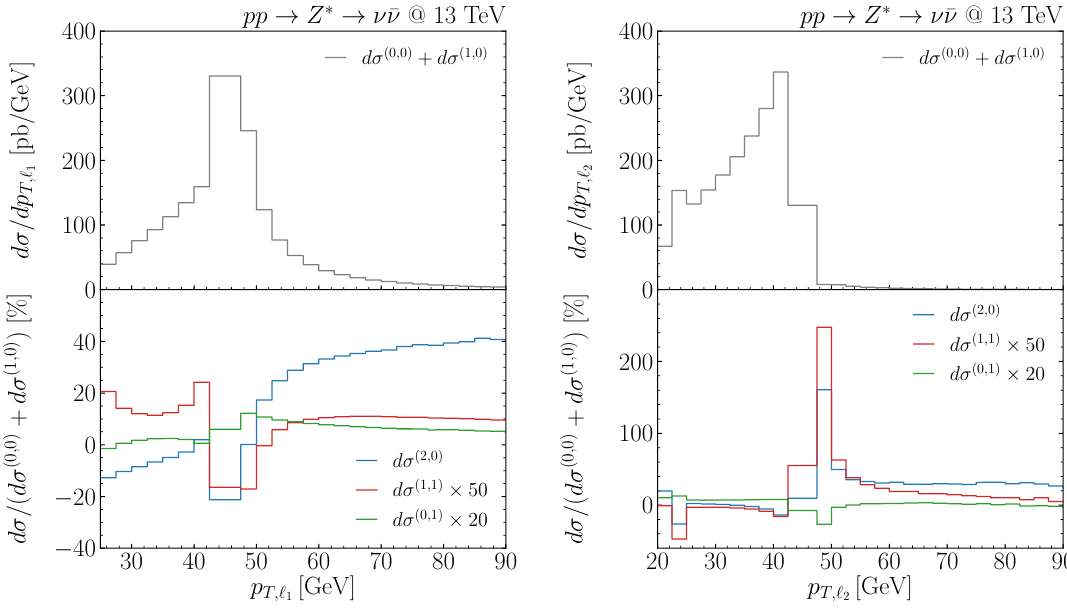
Figure 1 . Transverse momentum distributions for the hardest (left) and softer (right) lepton. The upper panel shows the NLO QCD prediction, while the lower panel shows the NNLO QCD (blue), NLO QED (green) and mixed (red) corrections, normalized to the NLO